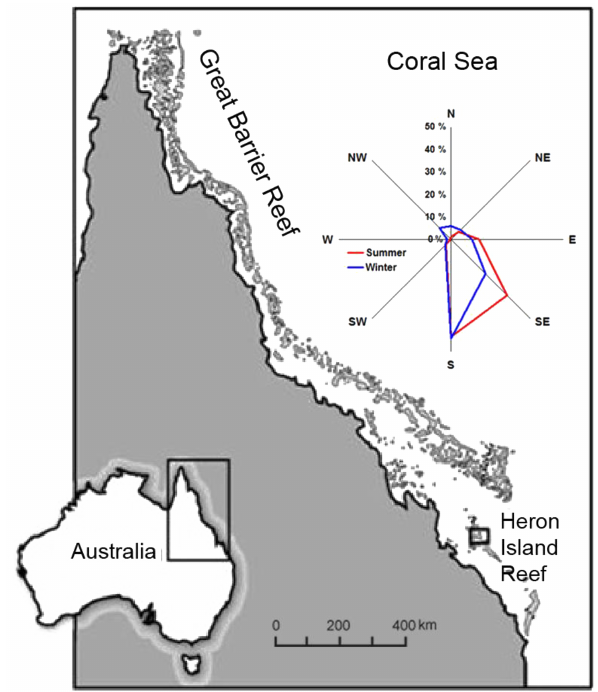
Figure 2. Location of Heron Island in the southern Great Barrier Reef, Australia, where continuous on-site analysis of DMS a was conducted in the austral wet season of 2012 and dry season of 2013. The compass shows the directional frequency of winds received at Heron Island during the late summer wet season (red line) and mid- winter dry season (blue line) measurement campaigns. Daily back- ward trajectory analysis showed that marine-derived air streams in the SE sector were received at Heron Island the majority of the time during both